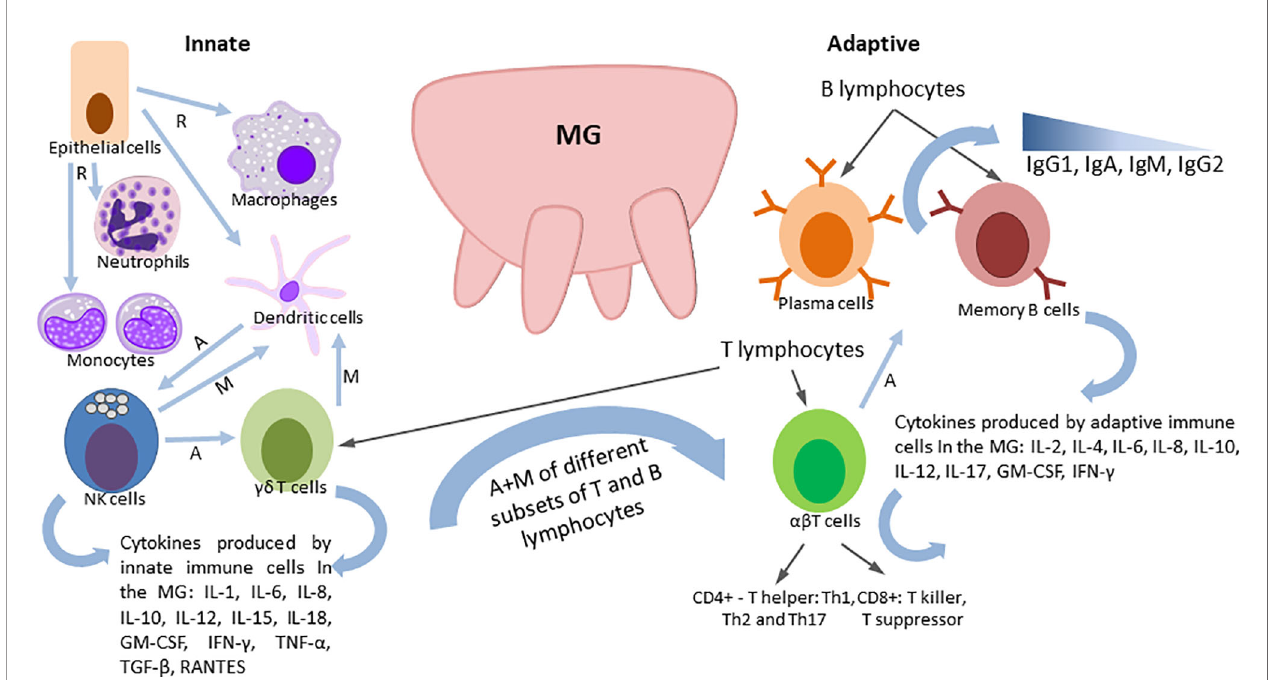
FIGURE 2 | Immune cells of the mammary gland (MG), their functions and cytokines